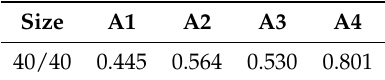
Figure 6. Organization of the latent space on the 40/40 model trained with regular reconstruction loss instead of cross-reconstruction loss. Table 3. Predictive accuracy of the quadratic classifiers for models trained with regular reconstruction loss instead of cross-reconstruction